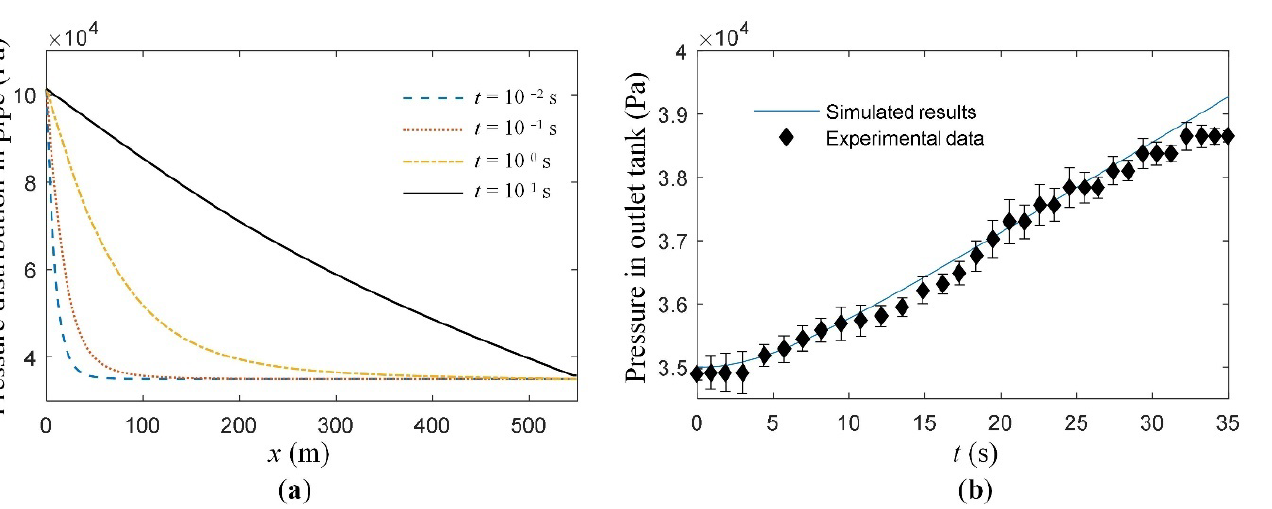
Figure 7. Calculated forces acted on the capsule at the initial stage. The dynamic pressure distribution in the system was also predicted by simulation and presented in Figure 8. As soon as the process is initiated, the inlet pressure step into the atmosphere. Consequently, the pressure near the inlet increases rapidly while in the rest sections the pressure maintains at the initial level. As air flows forwards to the outlet, the overall pressure distribution evolves from a sharp profile at first to a linear profile generally, as shown in Figure 8a. The simulated dynamic pressure at the outlet (tank pressure) is compared with the experimentally measured results, which demonstrates high agreement again as shown in Figure 8b.